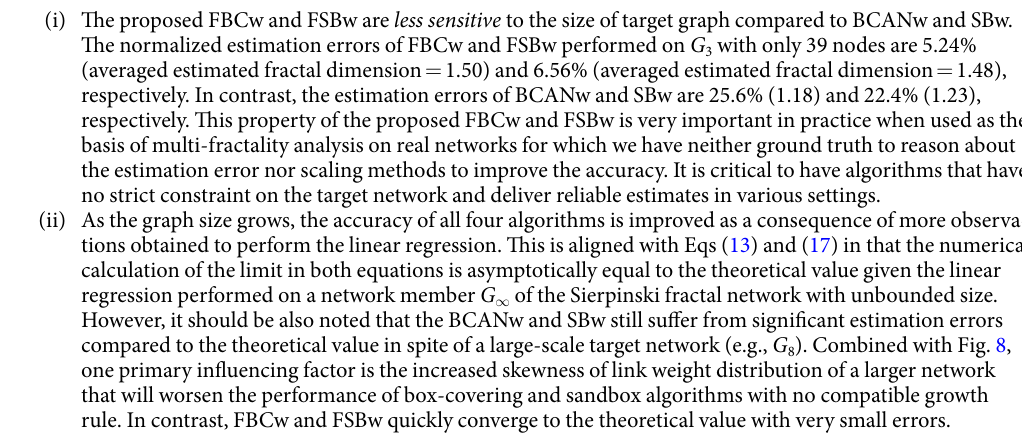
(i) The proposed FBCw and FSBw are less sensitive to the size of target graph compared to BCANw and SBw. The normalized estimation errors of FBCw and FSBw performed on G 3 with only 39 nodes are 5.24% (averaged estimated fractal dimension = 1.50) and 6.56% (averaged estimated fractal dimension = 1.48), respectively. In contrast, the estimation errors of BCANw and SBw are 25.6% (1.18) and 22.4% (1.23), respectively. This property of the proposed FBCw and FSBw is very important in practice when used as the